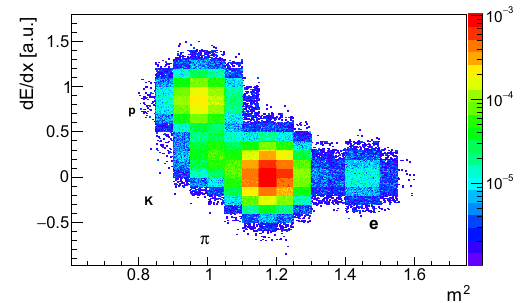
Fig. 4 Generated dE/dx and m 2 distribution in p + p interactions at 158 GeV/c beam momentum in EPOS